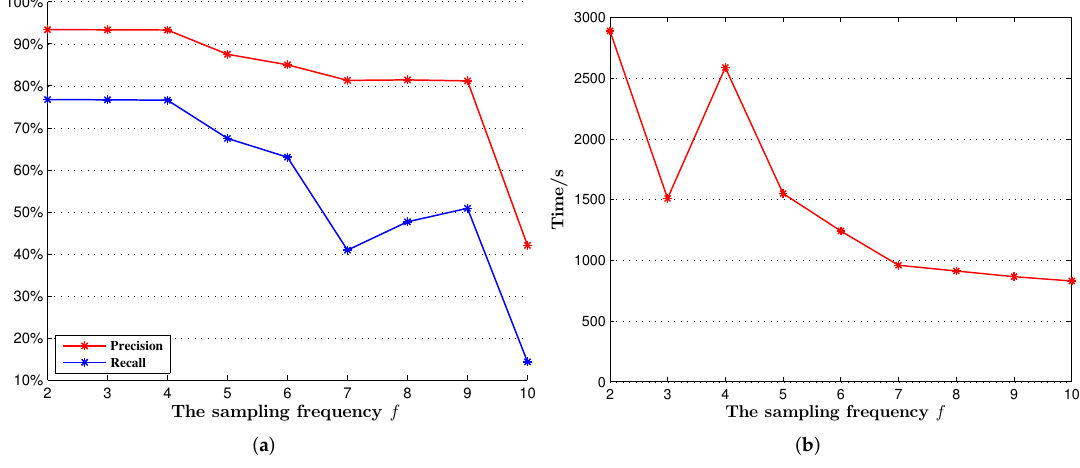
Figure 6. Average precision, recall and running time are relative to the sampling frequency f : ( a ) Average precision and recall with different sampling frequencies. ( b ) Running time with different sampling